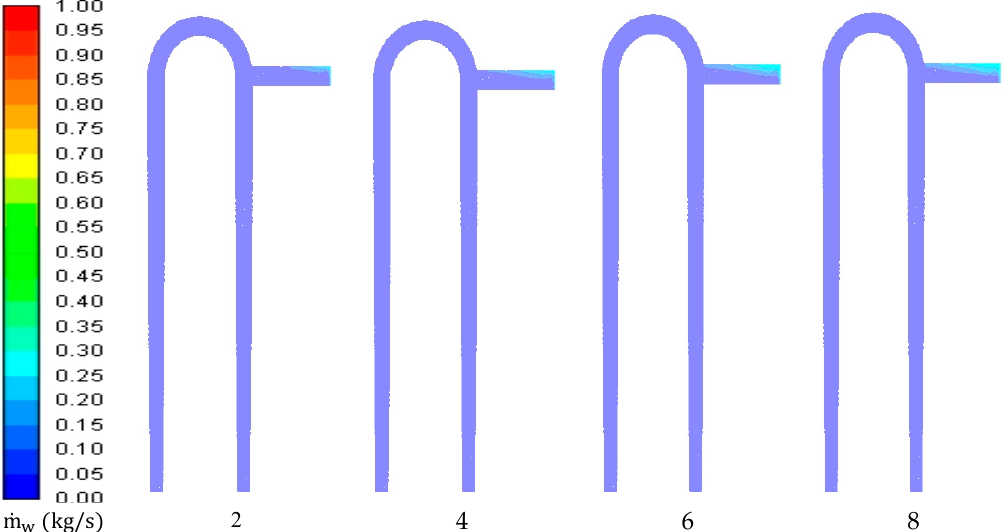
Figure 19. Vapor volume fraction contours at di ff erent flow ratios and X w = 4306.59, α m = 0.2 and X v = 0.1.